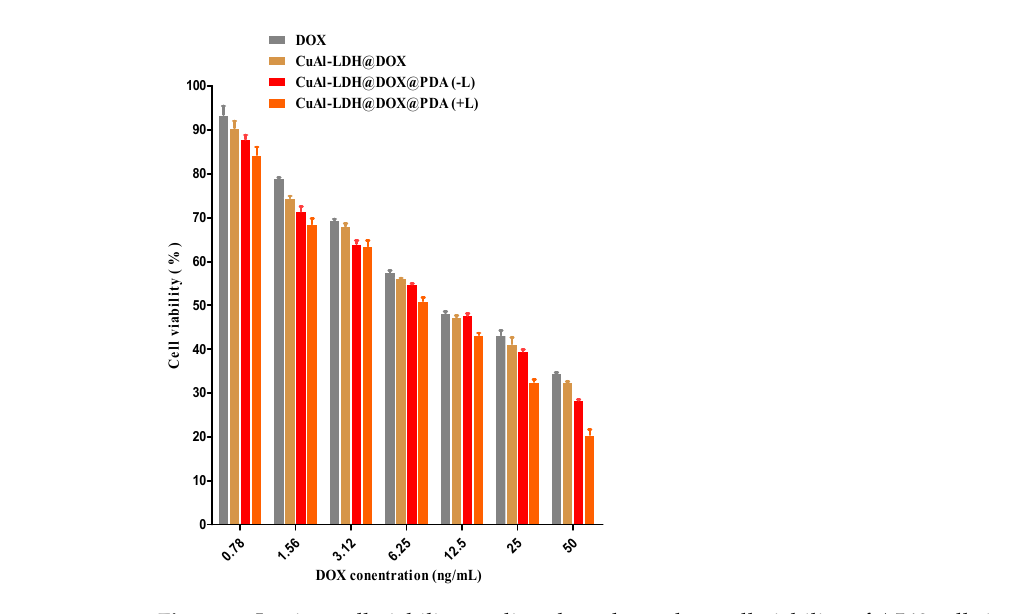
Figure 5. In vitro cell viability studies, dose-dependent cell viability of A549 cells incubated with